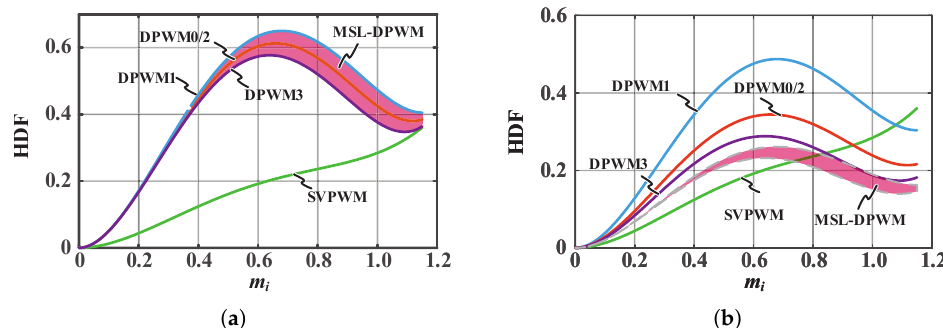
Figure 7. Comparison of the harmonic distortion factor, HDF, with different PWM methods ( a ) at k f = 1 and ( b ) at k f = SLF max .